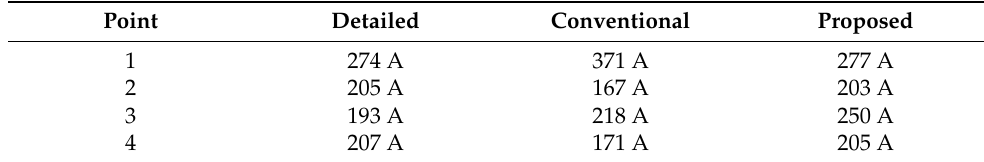
Table 3. Comparison of peak current values by points.